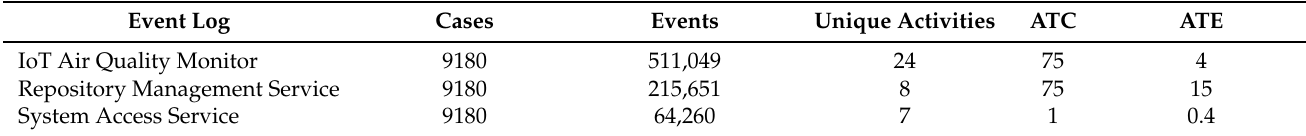
Table 3. Metrics of each event log